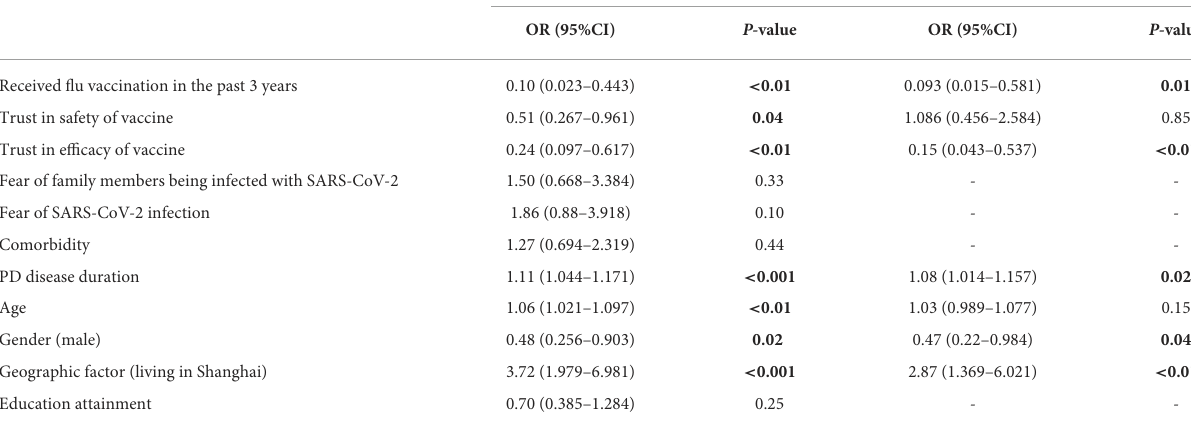
TABLE 5 Factors associated with COVID-19 vaccine